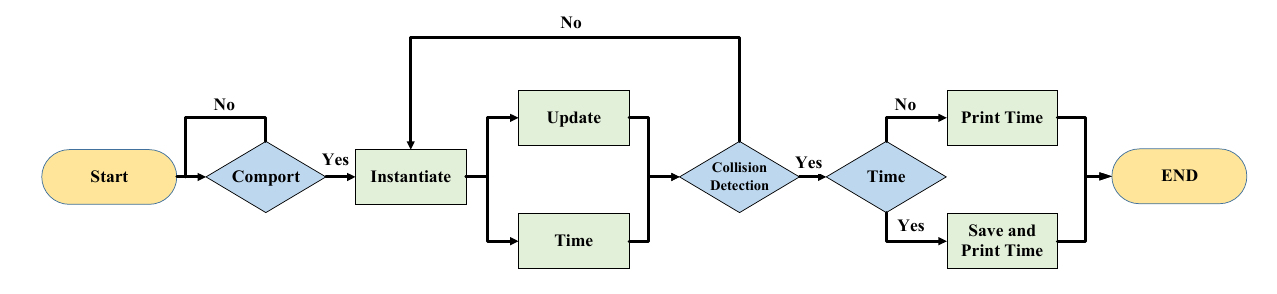
Figure 17. VR system flowchart.